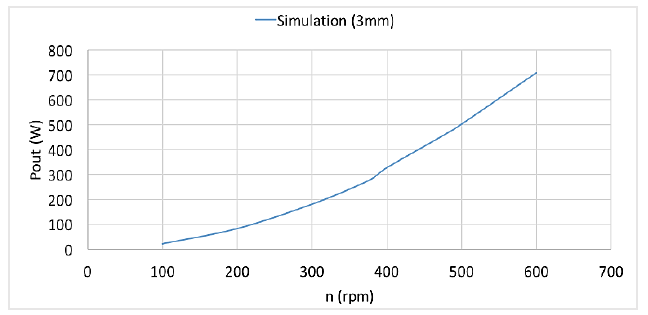
Figure 5. Plot versus the speed of the power output with 3 mm air gaps, simulation